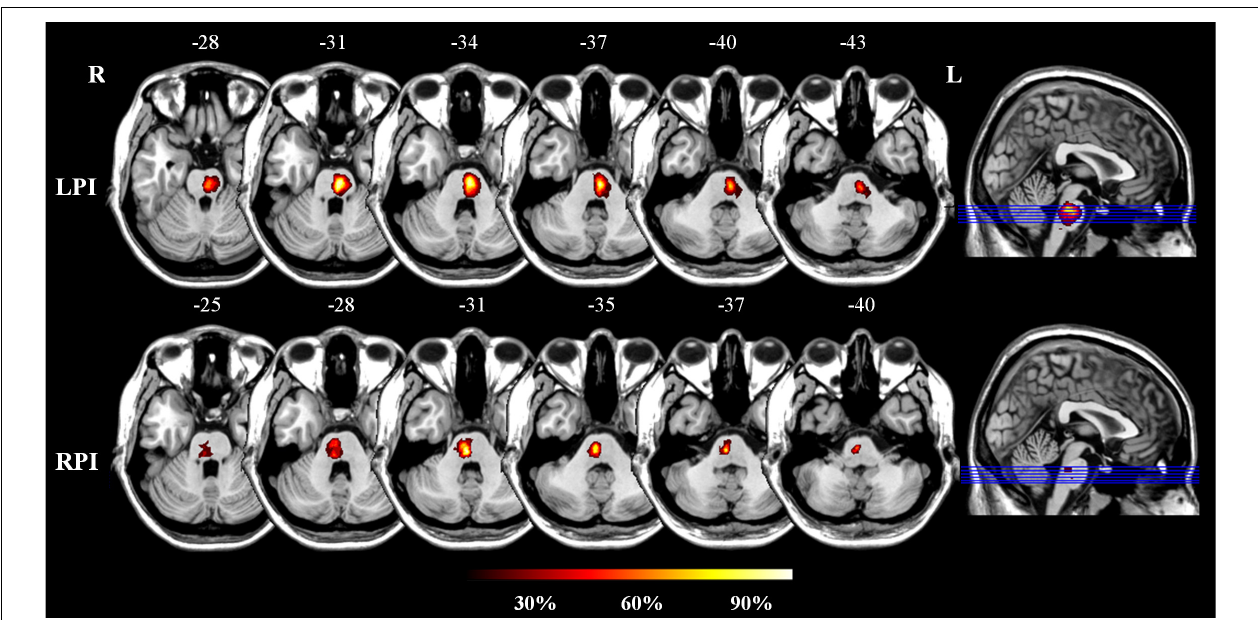
FIGURE 1 | The lesion probability distribution maps in the LPI and RPI groups. The color bar represents the lesion probability. L and R, left and right hemisphere; LPI and RPI, left and right pontine infarction